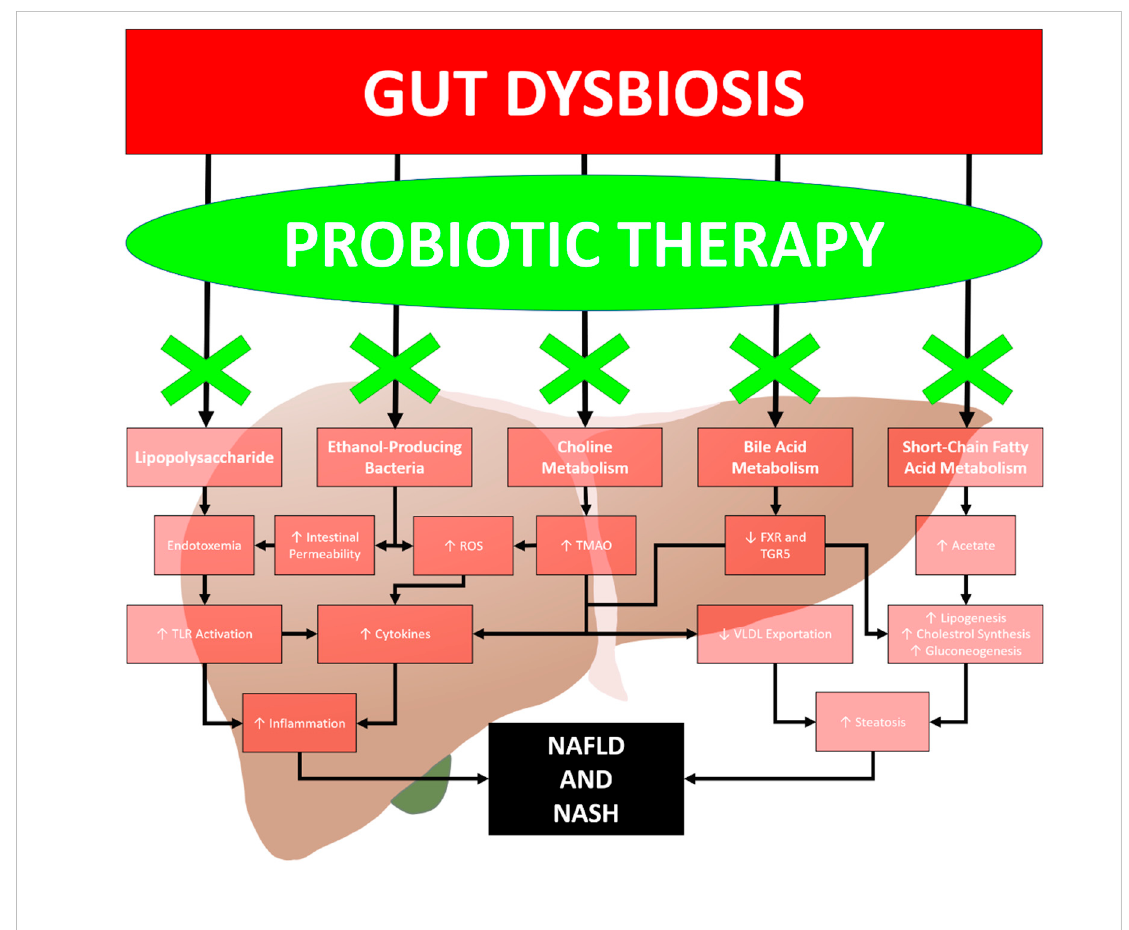
Figure 1. The proposed role of probiotics in NAFLD therapy [5–30]. ROS = reactive oxygen species; TMAO = trimethylamine N-oxide; FXR = farnesoid X receptor; TGR5 = G-protein coupled bile salt receptor 1; TLR = toll-like receptor; VLDL = very-low-density lipoprotein; NAFLD = non-alcoholic fatty liver disease; NASH = non-alcoholic steatohepatitis.